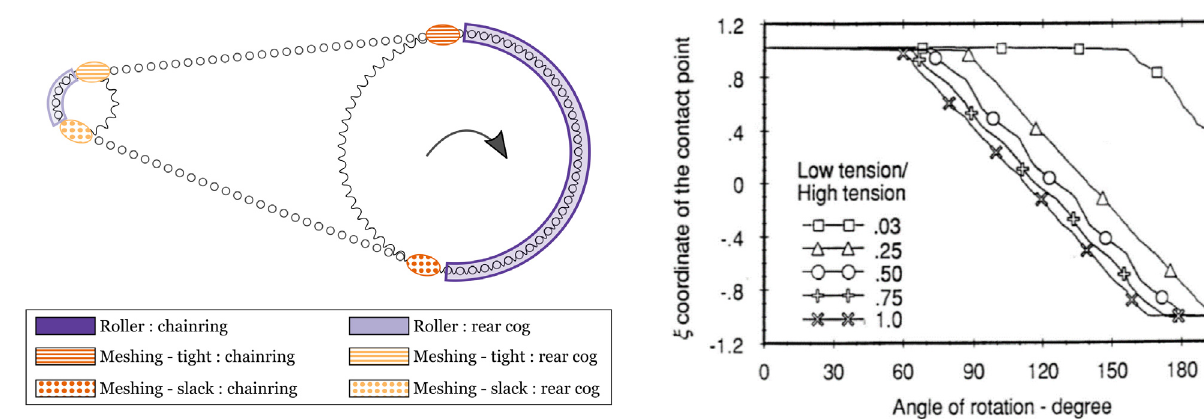
Fig. 20. Evolution of j for various T s / T t